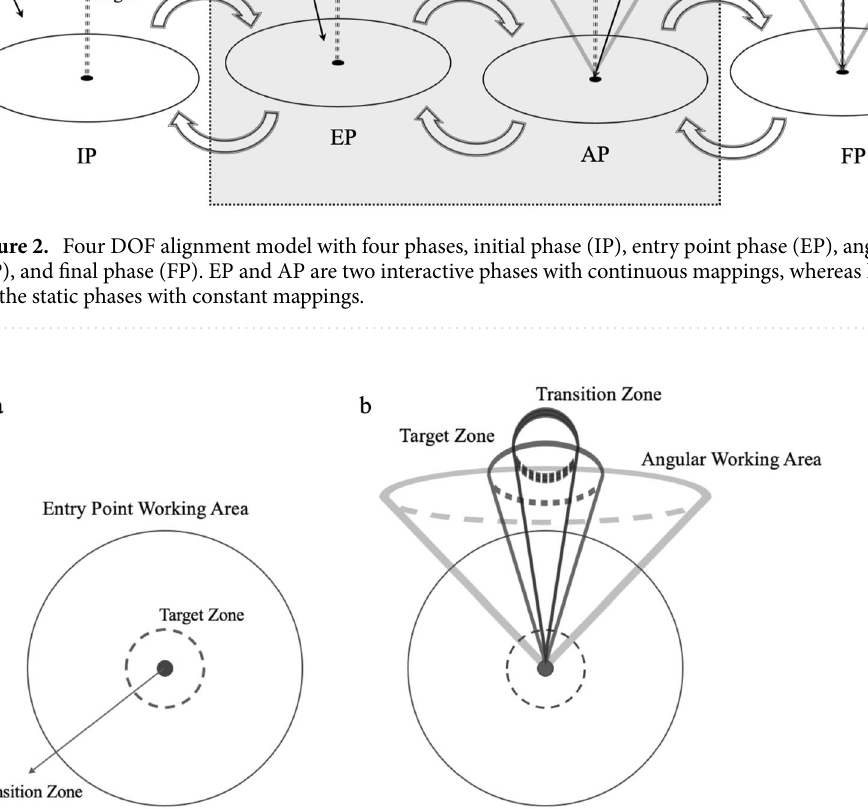
Figure 3. Illustration of the thresholds for transition between phases. ( a ) the circles demonstrate thresholds for the transition between IP, EP and AP; ( b ) the cones represent the thresholds for transition between AP and